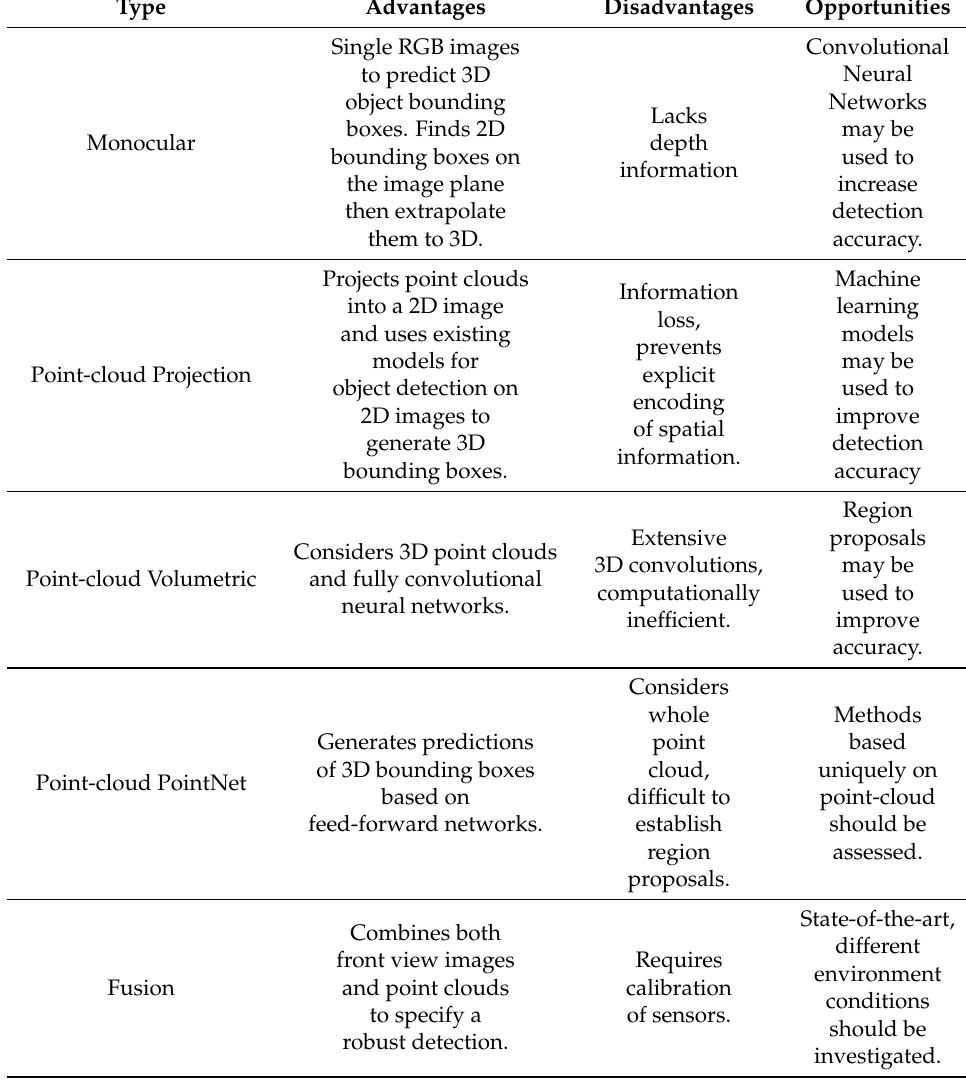
Table 1. Taxonomy of 3D Objects Detection